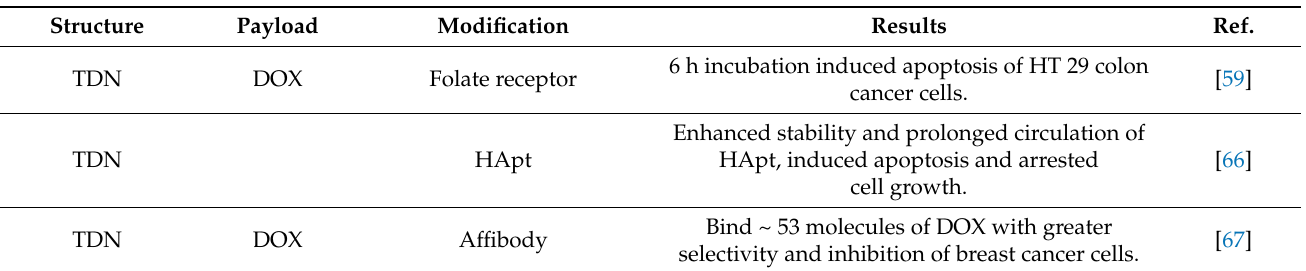
Table 2. DNA nanostructures in cancer